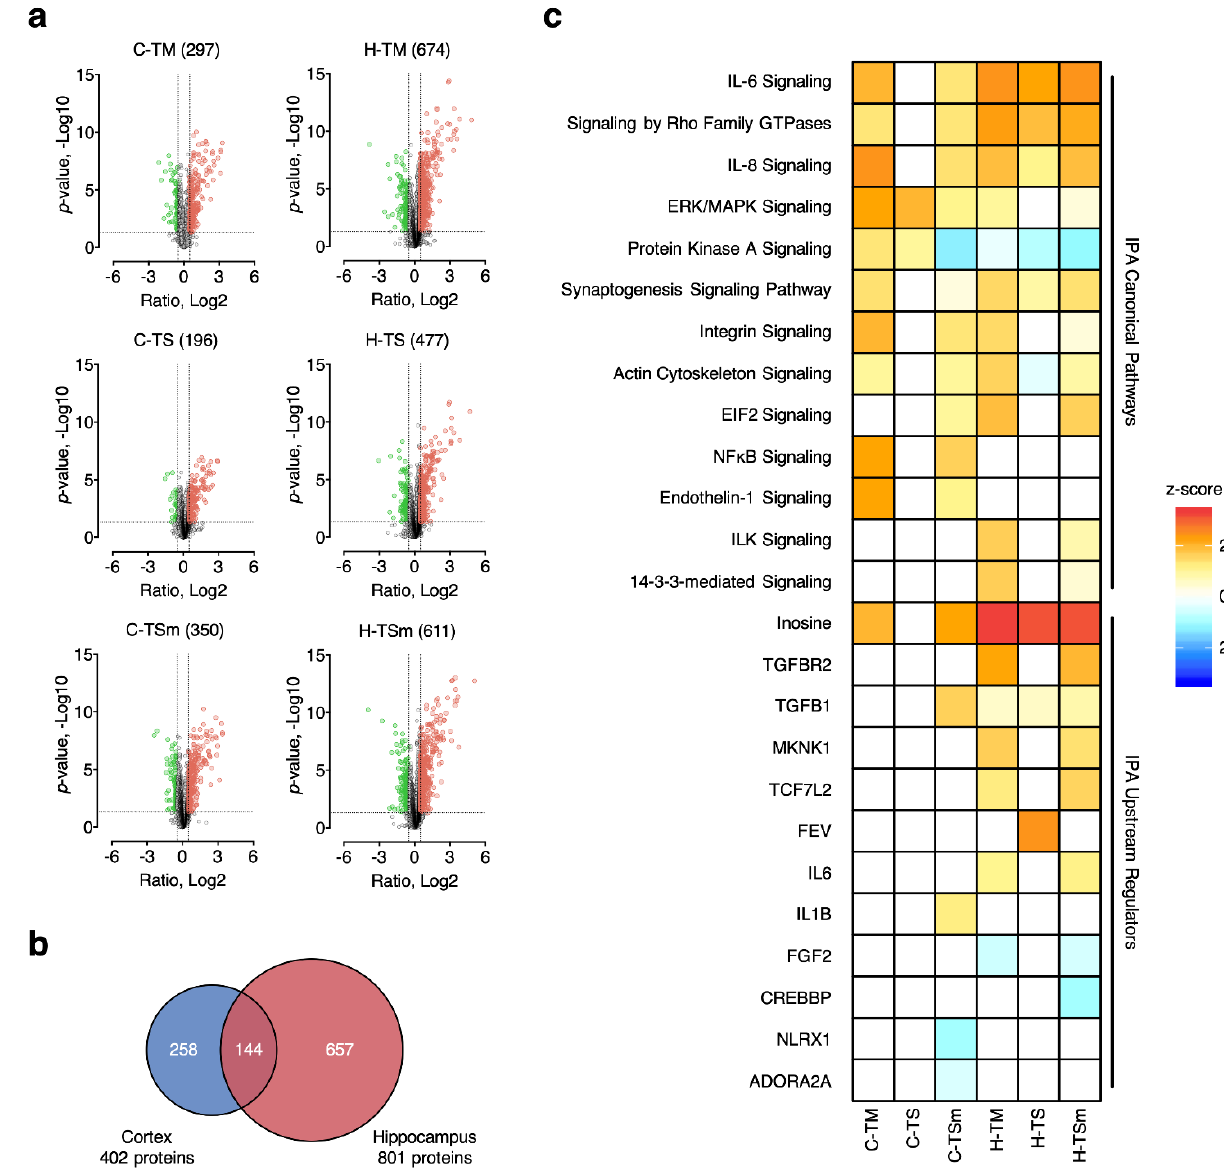
Figure 2. Determination of altered proteins (APs) in mild TBI (TM), severe TBI (TS), and severe TBI + methamphetamine (MA) (TSm) groups. ( a ) Volcano plots of protein ratios (x-axis) and p -values (y-axis) for each TBI group; ( b ) Venn diagram of APs identified in the cortex and hippocampus; ( c ) canonical pathways (upper) and upstream regulators (lower) enriched from APs by Ingenuity Pathway Analysis (IPA).